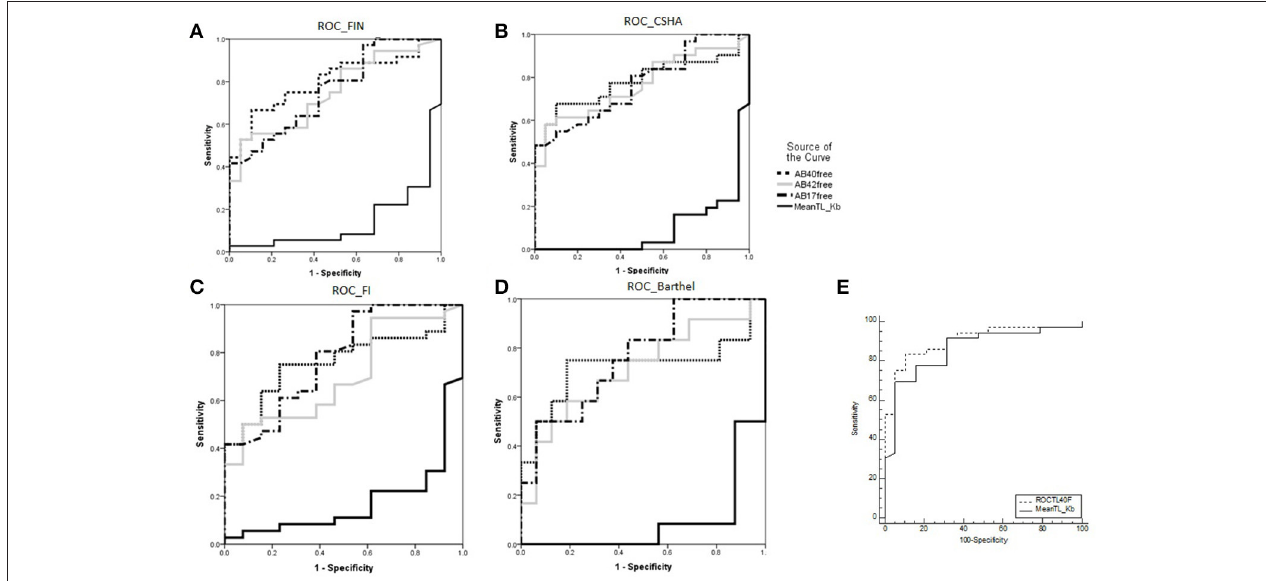
FIGURE 2 | (A) ROC curves and areas under the curve (AUCs) for A β 40, A β 42, and A β 17 levels and telomere length for discriminating the functionally impaired non-agenarian group. (B–D) The same variables’ discriminating power for higher frailty and dependency measured by CSHA, FI and Barthel Index. E ): “Composite Neurologically Healthy Aging Score”: combined ROC curve and AUC for mean telomere length and total plasma Ab40 (TP40) vs. mean telomere length alone. *AUC for telomere length was 0.133, it being inversely correlated with functionally impaired aging (i.e., functionally impaired nonagenarians are more likely to have shorter